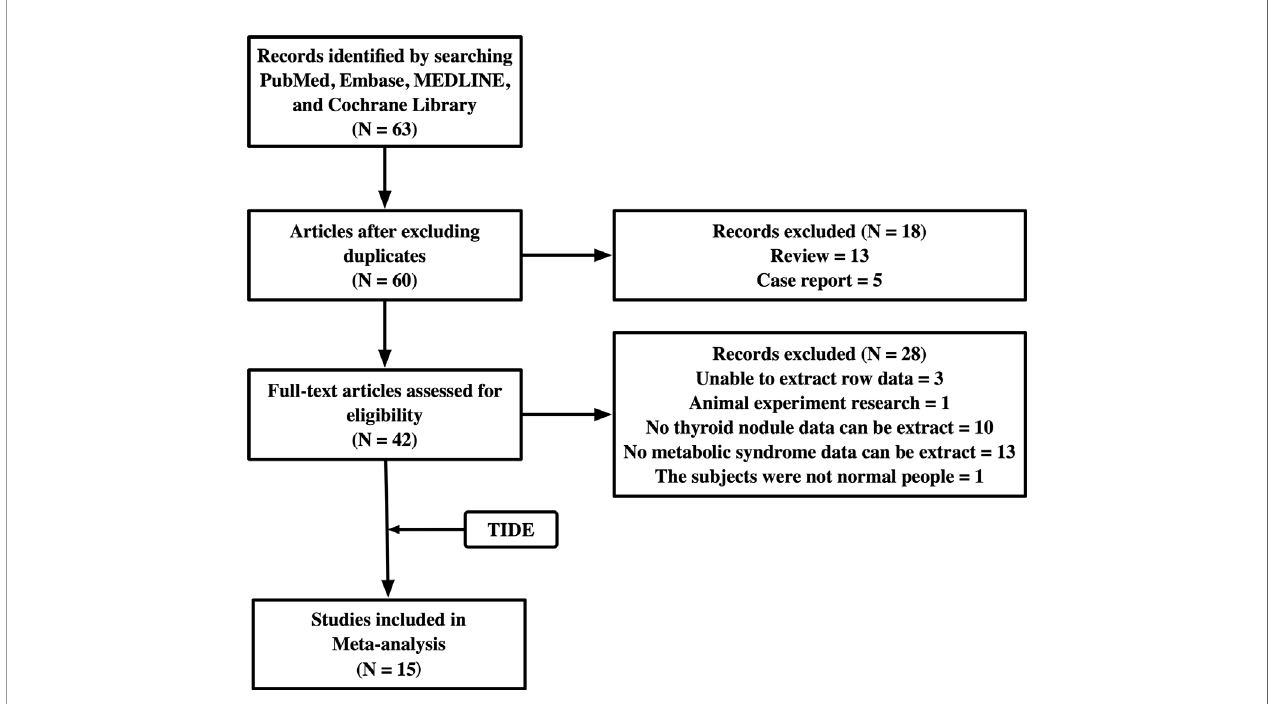
FIGURE 1 | Flow chart of the study selection